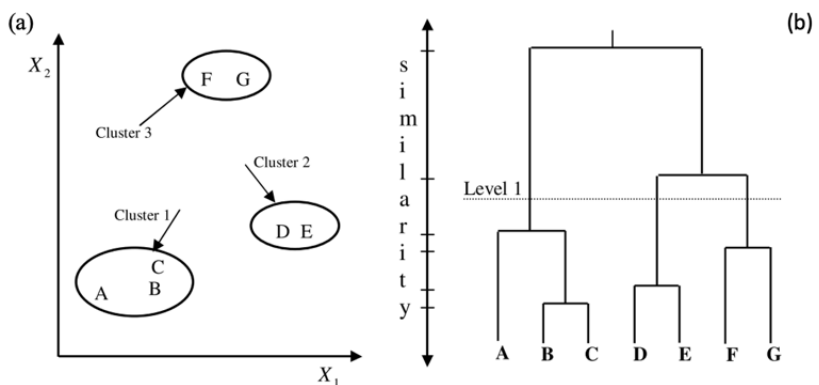
Figure 21. The two-dimensional dataset ( a ) and dendrogram obtained using single-link algorithm ( b )